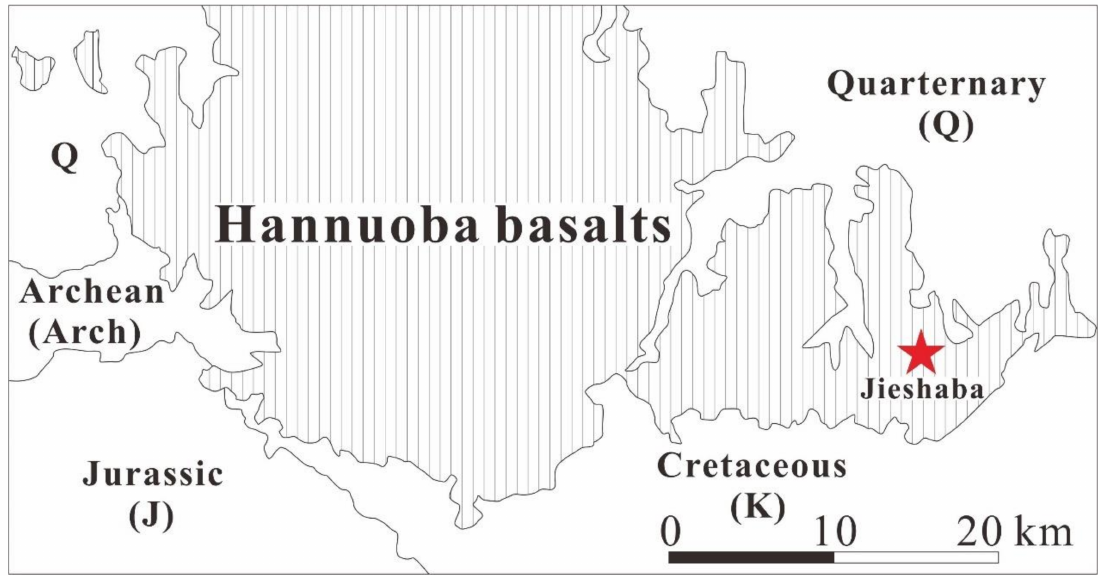
Figure 2. Sampling location of the websterite studied. Note: The red star indicates the sam- pling location. Stratigraphic abbreviations: Arch—Archean terrain, J—Jurassic, K—Cretaceous, Q—Quarternary (modified after Zhou et al.